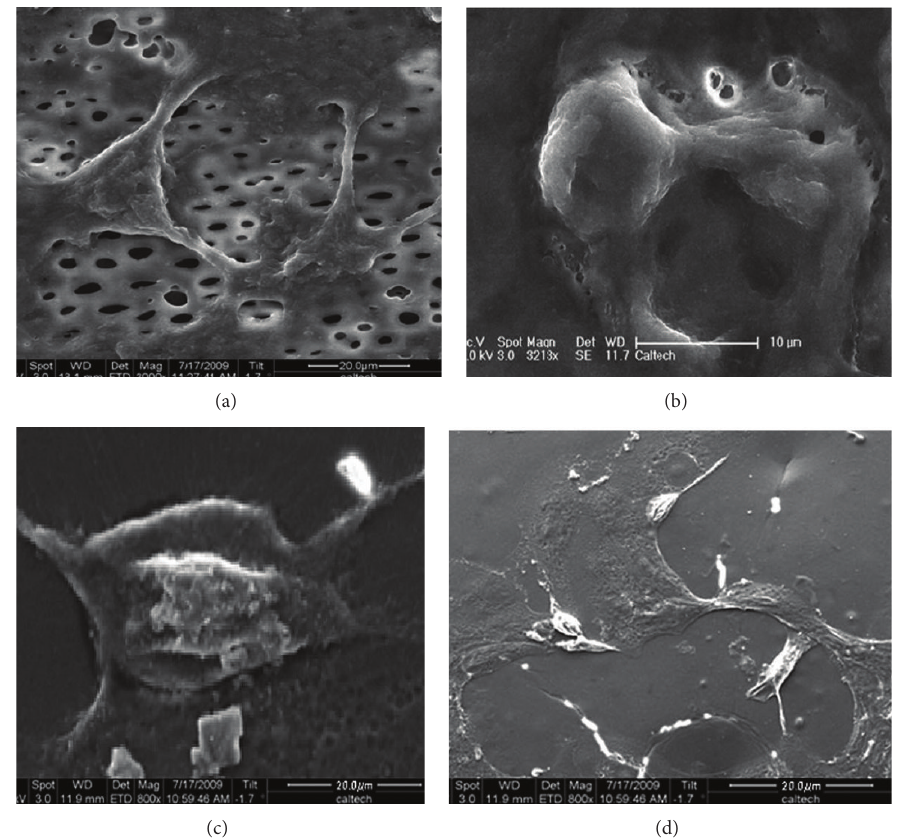
Figure 1: SEM micrographs of hFOB 1.19 cells cultured on the (a) PLLA/CNT spun film, (b) PLLA spun film, (c) PLLA/CNT 3D bonelike PAM scaffold, and (d) PLLA 3D bonelike PAM scaffold